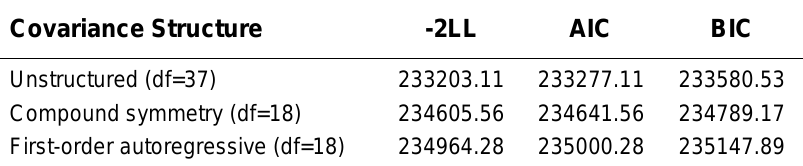
Results of Information Criterion among Three Covariance Structure